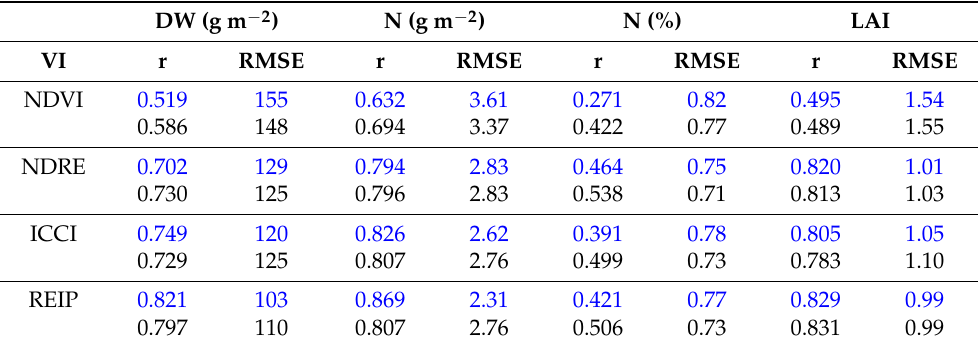
Figure 5. Correlation between wheat above ground N uptake and REIP, retrieved by VENµS and Sentinel-2 (L1), based on sampling average (per field*day). Table 3. Correlation between Sentinel-2- (blue) and VENµS-based vegetation indices (VI) and wheat biomass (dry weight, DW), N content, N concentration, and LAI based on sampling average (per field*day).